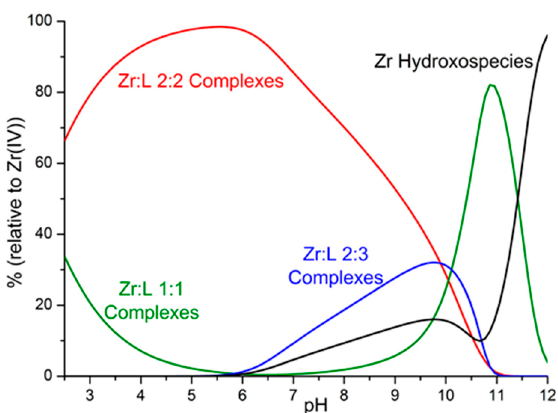
Figure 2. Distribution diagram of the complexes formed in the Zr 4 + –desferrioxamine system representing the overall percentages of 1:1, 2:2, and 2:3 metal-to-ligand and hydroxo complexes, obtained by means of the Hyss program [12] on the basis of the determined equilibrium constants. Desferrioxamine = L; [Zr 4 + ] = [L] = 1 mM. Charges omitted.